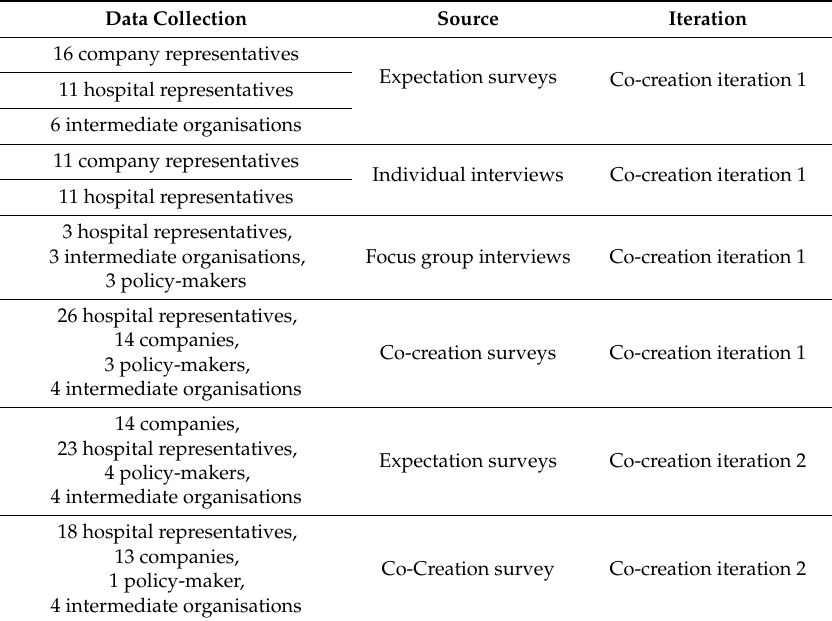
Table 2. Data collection in the inDemand